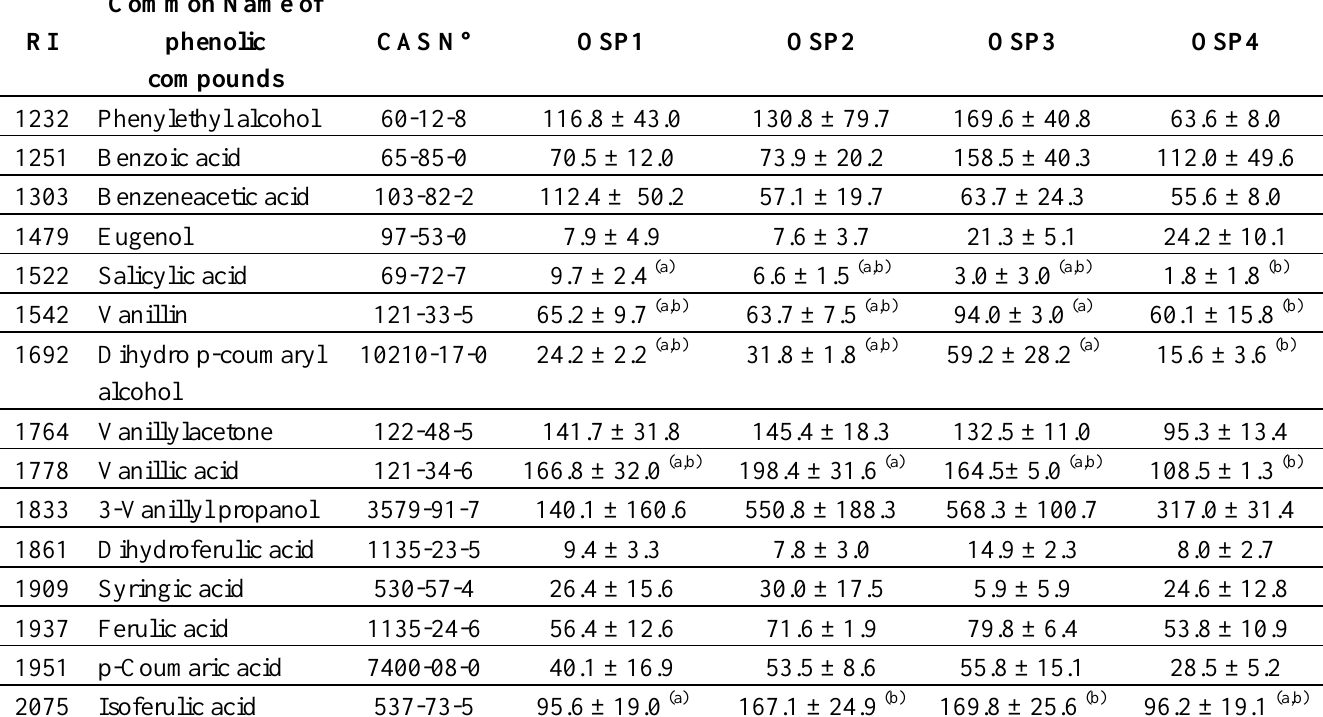
Table 1. Mean concentrations (µg/g of dry matter ± standard error) of simple phenolic compounds in the needles of Pinus laricio in Ospedale forest (a,b: significant difference between stations, Anova, p<0.05); RI= Kovats Retention Index; CAS N°: